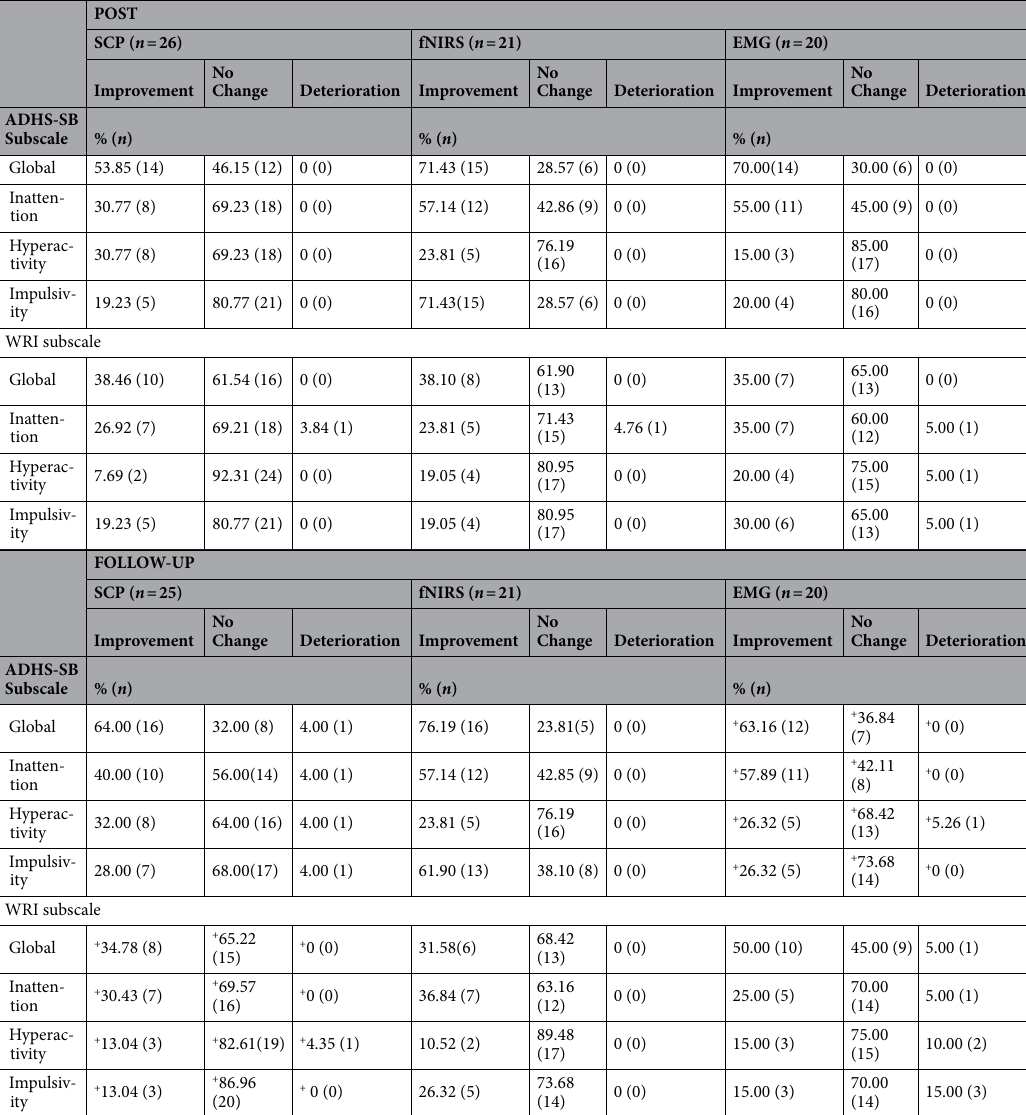
Table 4. Categorization of clinically significant change. Note: Reliable Change Index (RCI) was based on change from pre- to post test and from pre test to follow-up. Reliable improvement is defined as RCI ≤